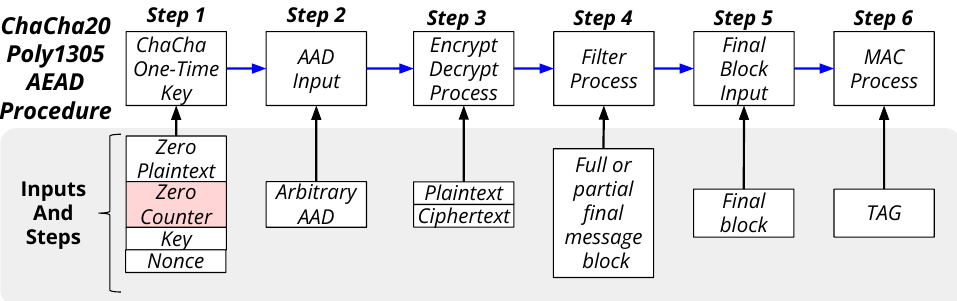
Figure 3. ChaCha20-Poly1305 AEAD procedure.